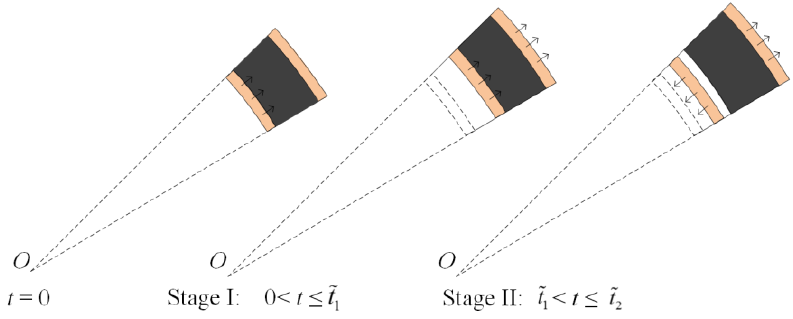
Figure 8. Deformation process of the third phase.